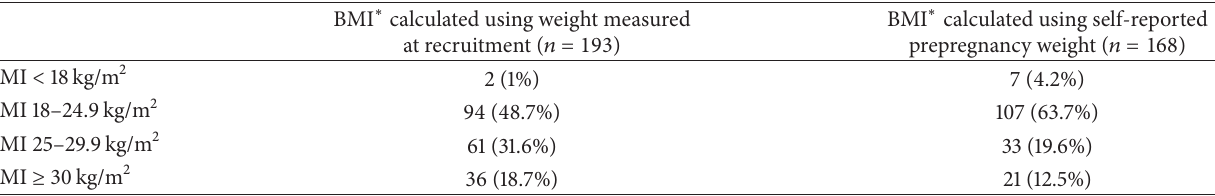
Table 1: Body Mass Index (BMI) classifications of participants calculated using weight measured at recruitment and self-reported prepregnancy weight.